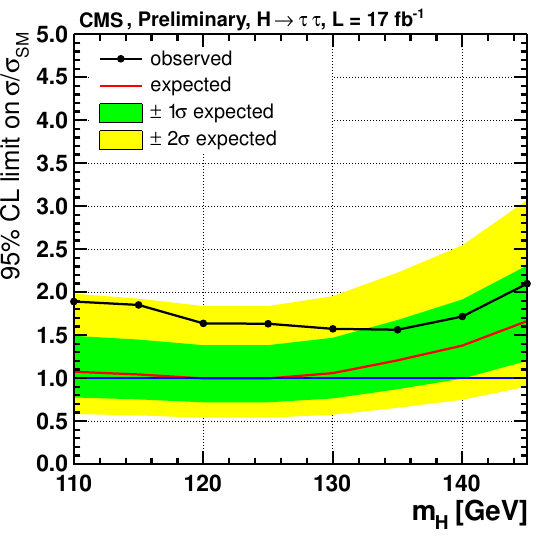
Figure 4. Expected and observed 95% CL upper limit for the observation of a SM Higgs boson for masses between 110 and 145 GeV. The red line indicates the expected limit, the yellow and green band indicate the one and two σ uncertainty on the expected limit. The black points indicate the observed limit.